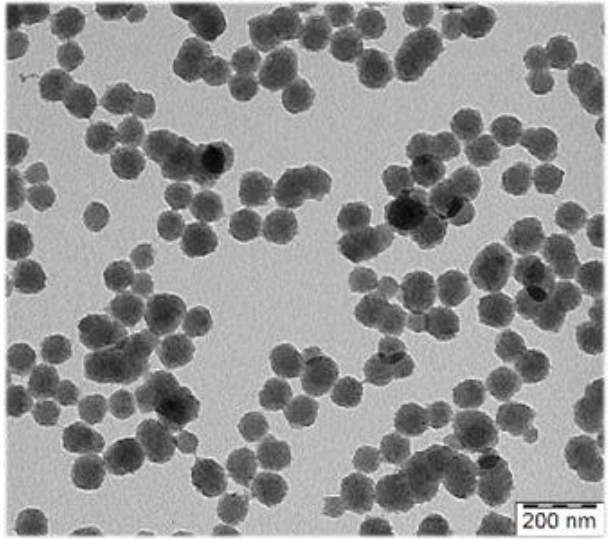
Figure 1. Transmission electron micrograph of polypyrrole particles prepared for photoacoustic im- aging.